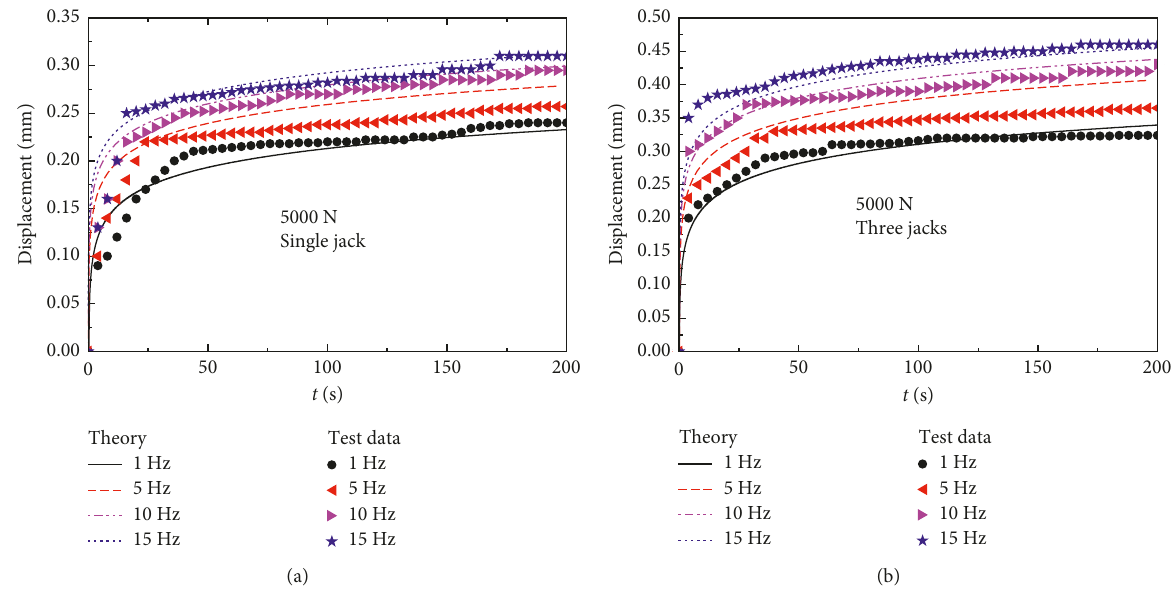
Figure 4: Displacement versus time curves under different excitation frequencies (sand bag): (a) single jack and (b) three jacks. Table 6: Acceleration a 2 ). 0.15 (m/s Number of Filling medium in subgrade jacks,